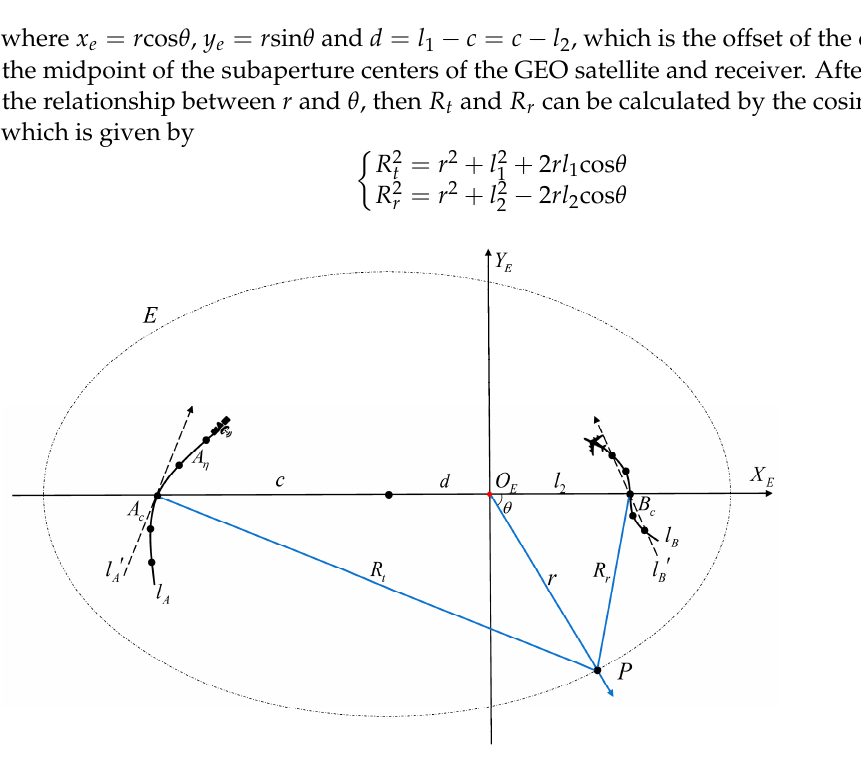
Figure 3. Plane geometry of the ellipse 𝐸 .